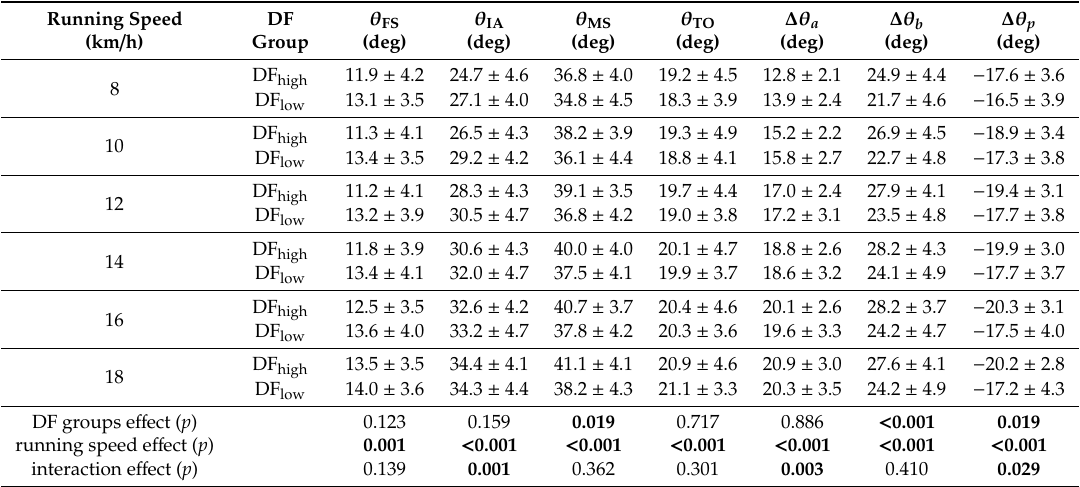
Table 4. Knee extension-flexion joint angle at specific events of the running stance ( θ FS , θ IA , θ MS , and θ TO ) and their range of motions during the di ff erent running stance phases ( ∆ θ a , ∆ θ b , and ∆ θ p ) for the high (DF high ) and low (DF low ) duty factor running groups at the di ff erent running speeds. Running Speed DF (km / h)